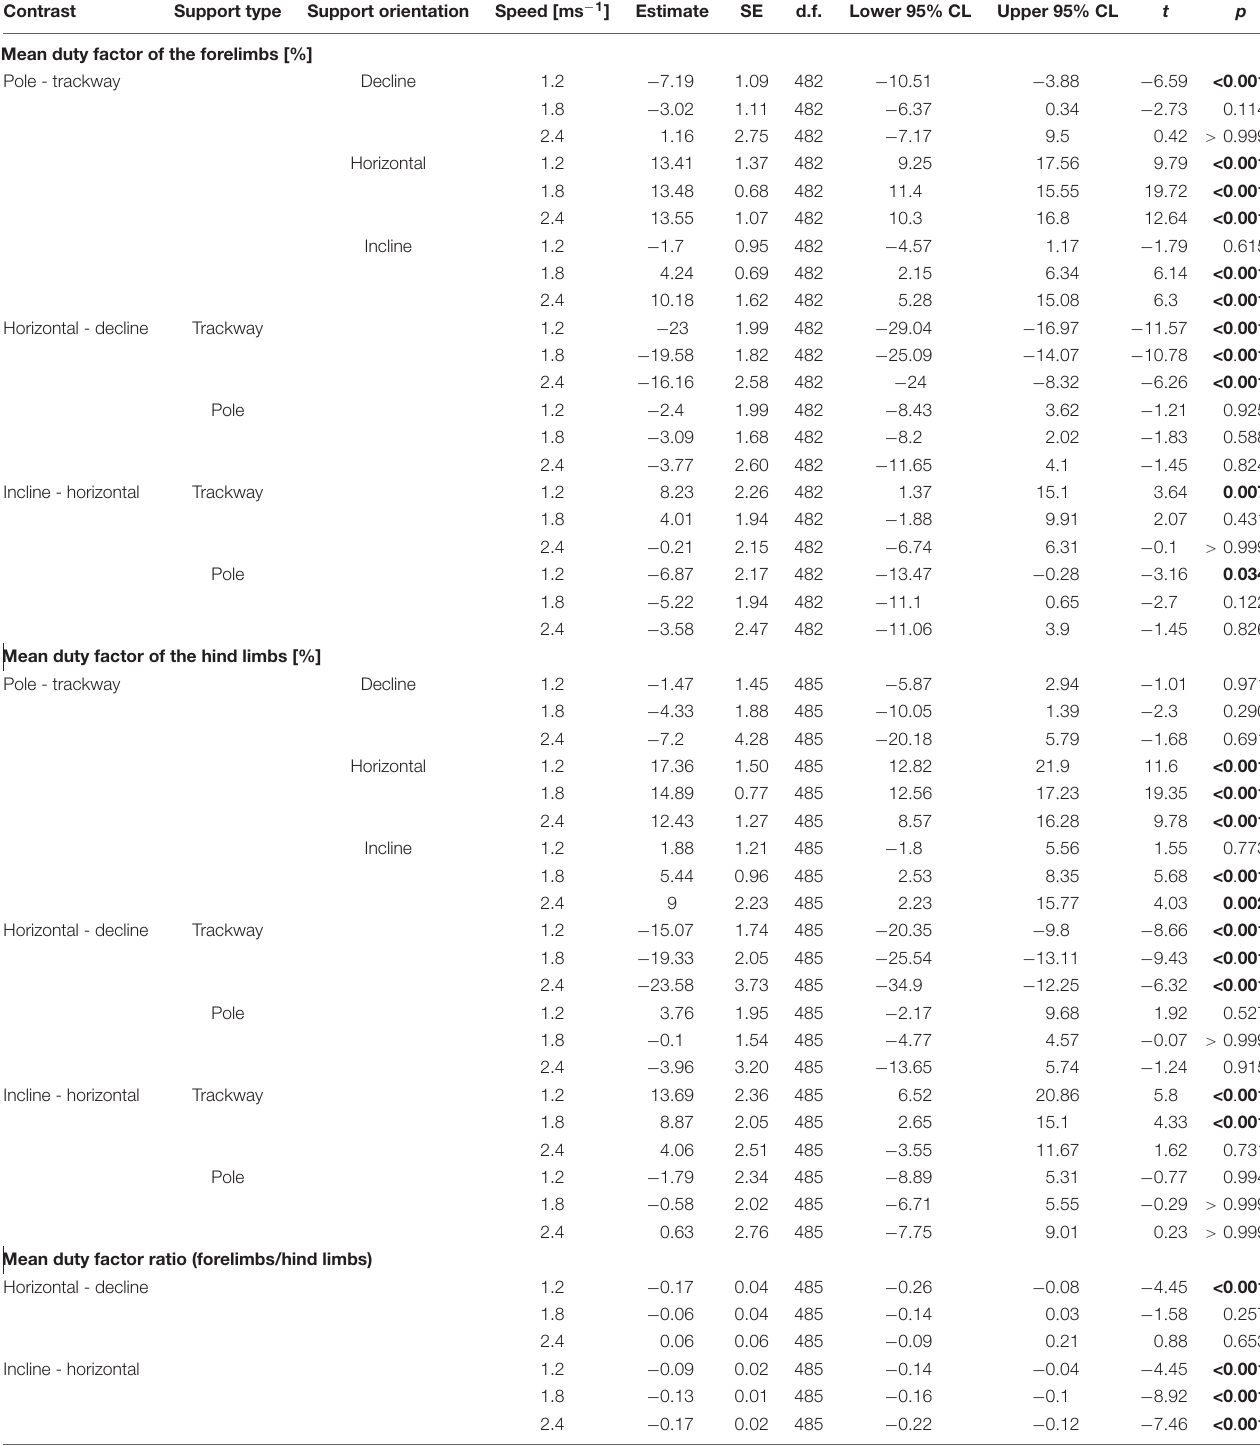
TABLE 3 | Post hoc contrasts for the regressions of duty factors and their ratio. Contrast Support